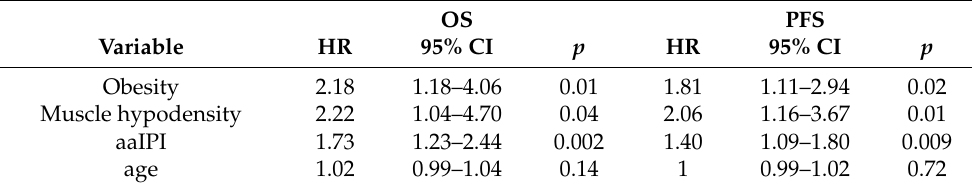
Table 5. Multivariate analysis on OS and PFS.